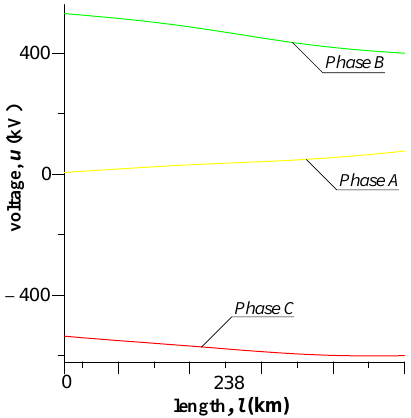
Figure 6. Phase voltage across the line as a function of distance at t = 0.01 s. At t = 0.01 s, the voltage (Figure 6) and current (Figure 7) vs. distance are nearly linear since, by then, electromagnetic waves were running repeatedly along the line to its end and back many times at identical parameters. The phase current across the line as a function of distance at t = 0.01 s from the time of the voltage turn-on is depicted in Figure 7.